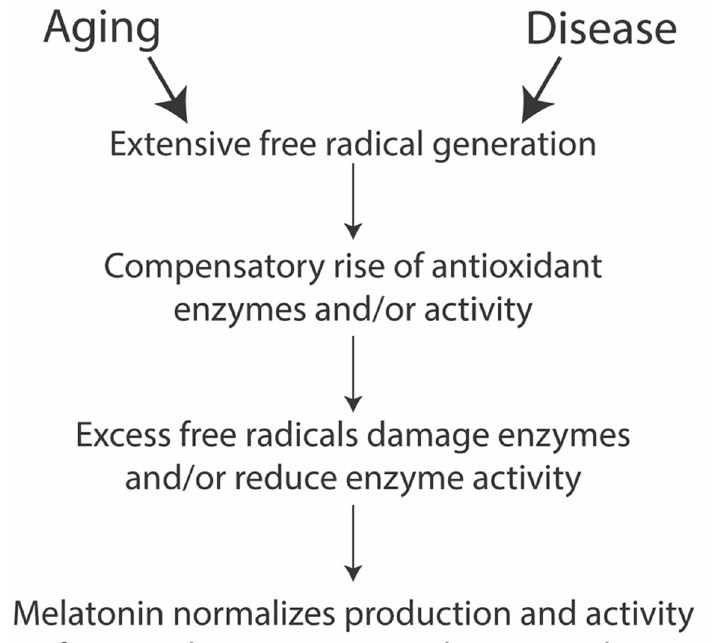
Figure 2. Simplified melatonin antioxidant cascade (drawn after